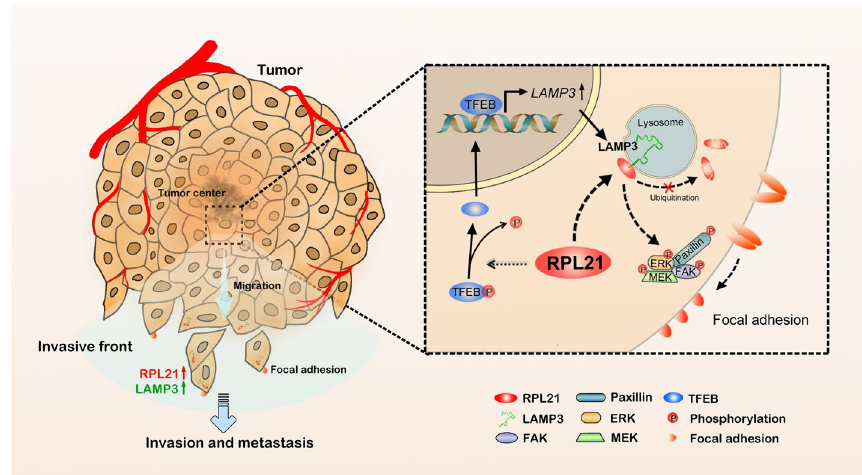
Fig. 7 Schematic diagram demonstrating the mechanism of RPL21 and LAMP3 to promote CRC metastasis. The high expression of RPL21 in CRC cells activated the transcriptional function of TFEB to upregulate the expression of LAMP3. The direct interaction between RPL21 and LAMP3 suppressed the ubiquitin– proteasome degradation of RPL21 and activated the FAK/paxillin/ERK signaling pathway to increase the formation of immature FAs, thereby promoting CRC cell migration, invasion, and tumor